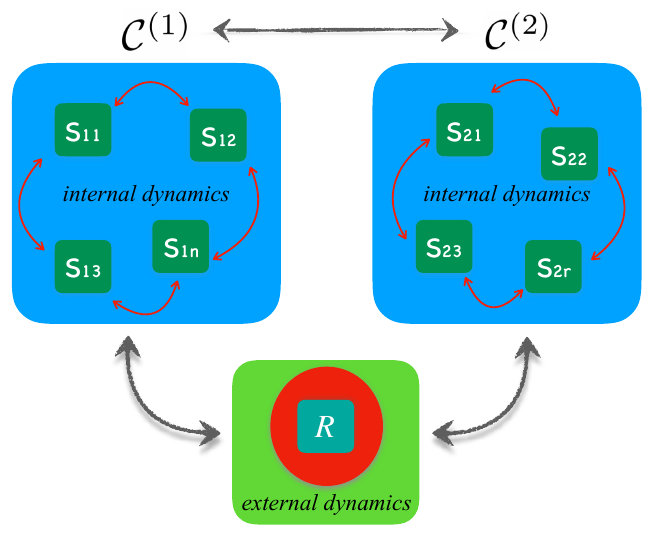
Figure 1. Schematic representation of the structure of the social-ecological model. Two epistemologi- cal communities C ( 1 ) and C ( 2 ) act on a single ecosystem to exploit the resource R . The interaction of the communities and the resource produces an external dynamic, consisting of the population changes of every subsystem involved ( C ( 1 ) , C ( 2 ) , . . . , R ). This is accounted for by the time behavior of the internal structure of each community i composed by actors and sectors with populations S a β with a = 1,2, . . . , n , β = 1,2, . . . , r that reflect several degrees and types of knowledge. The internal dynamics consist of the flux of populations among different knowledge sectors. The two epistemological communities may also interact between them. The figure is own